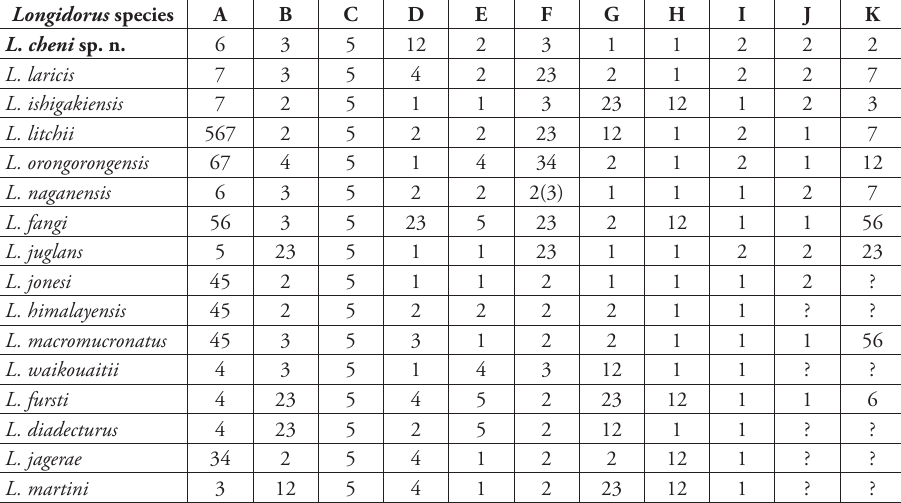
Table 3. Partial polytomous key of Longidorus species with guide ring at mid-odontostyle area includ- ing Longidorus cheni sp. n. based on polydomous key of Chen et al. (1997), Loof and Chen (1999) and Peneva et al. (2013).